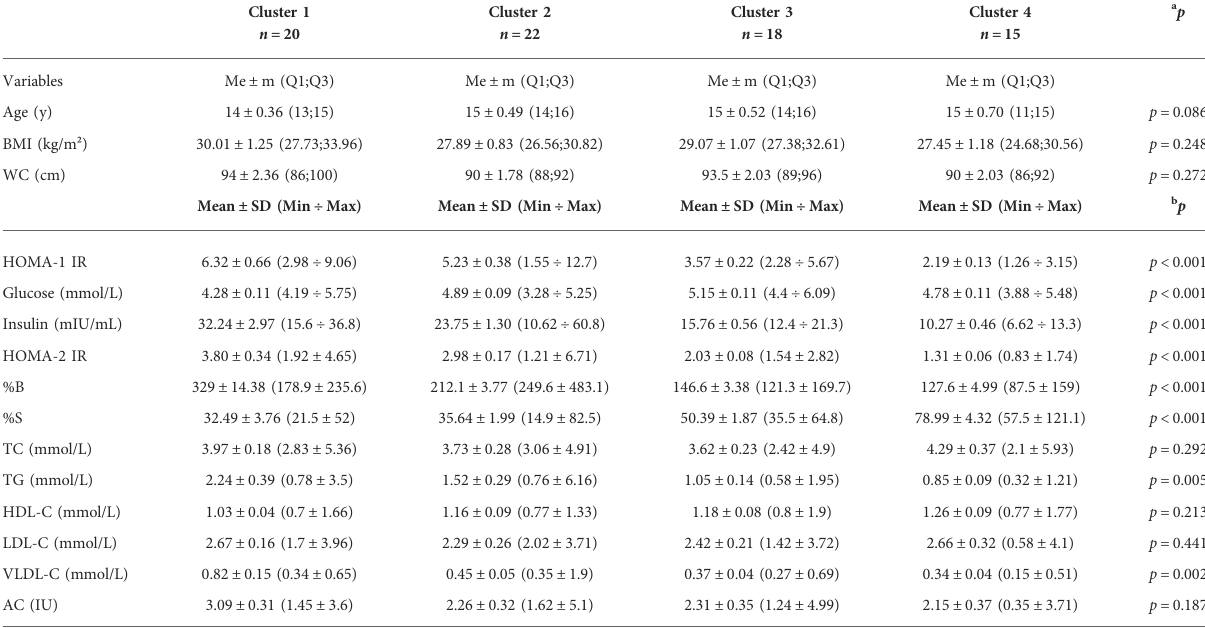
TABLE 1 Characteristics of the studied patients by subgroups